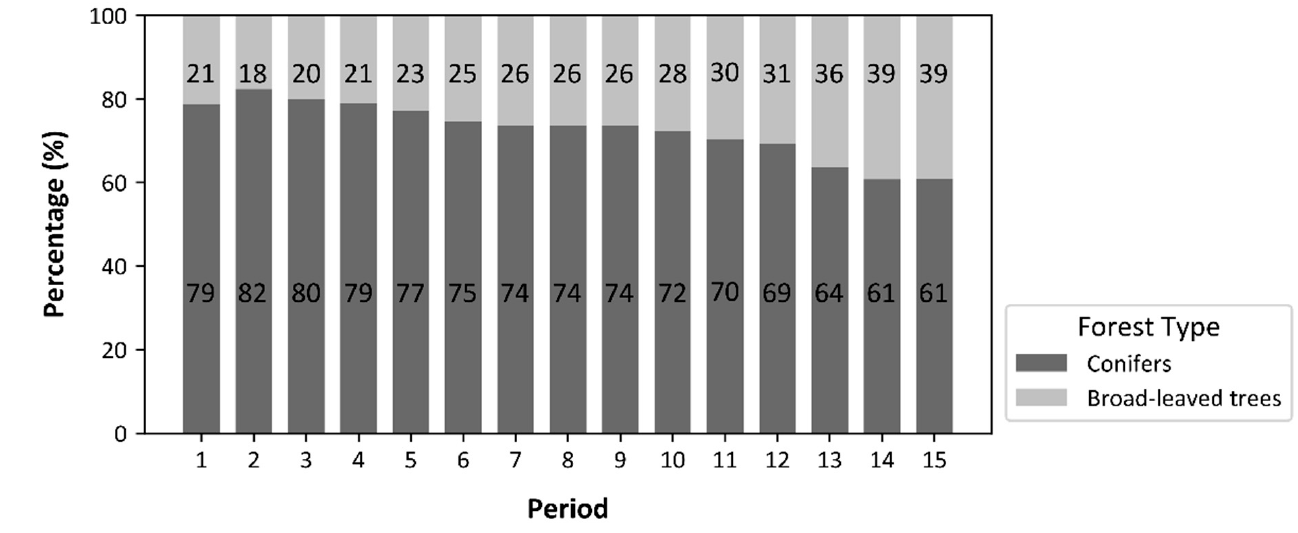
Figure 9. Proportion of conifers and broad-leaved trees by period.